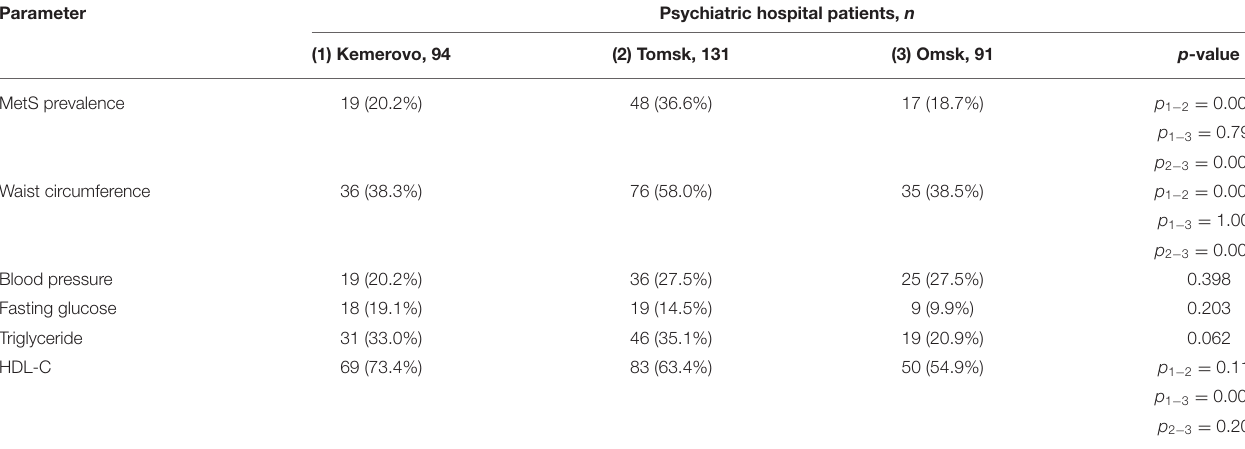
TABLE 10 | Prevalence of MetS and its criteria in the study population [ n (%)].